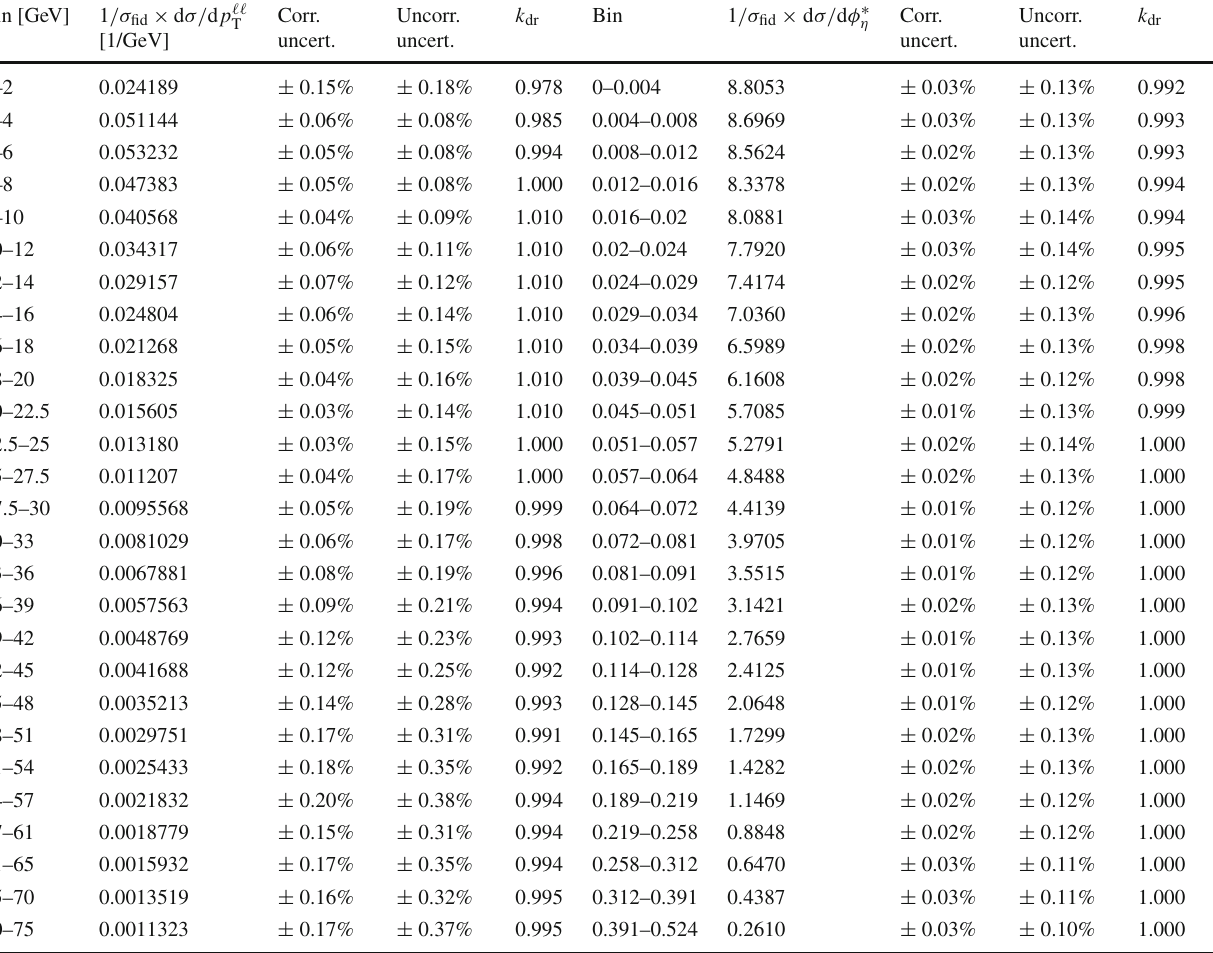
Table 4 The measured combined normalized differential cross-sections, divided by the bin-width, in the fiducial volume at Born level as well as a factor k dr to translate from the Born particle level to the dressed particle level Bin [ GeV